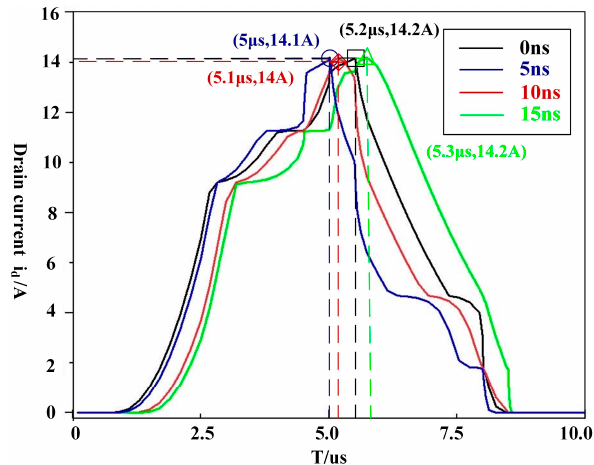
Figure 12. Simulation curves of i d and the 0 ns, 5 ns, 10 ns, and 15 ns values of t d